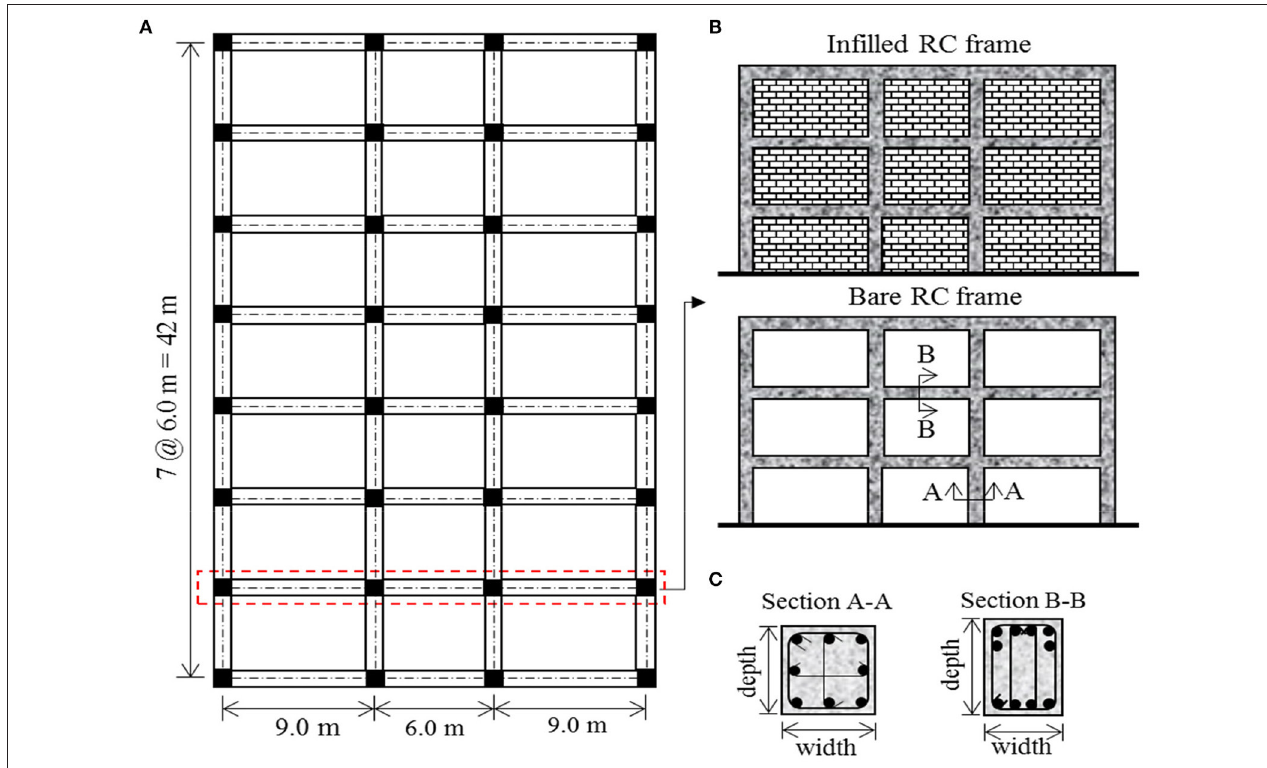
FIGURE 2 | Code-conforming RC frame buildings; (A) Frame plan, (B) Frame elevations and types, and (C) typical columns and beams